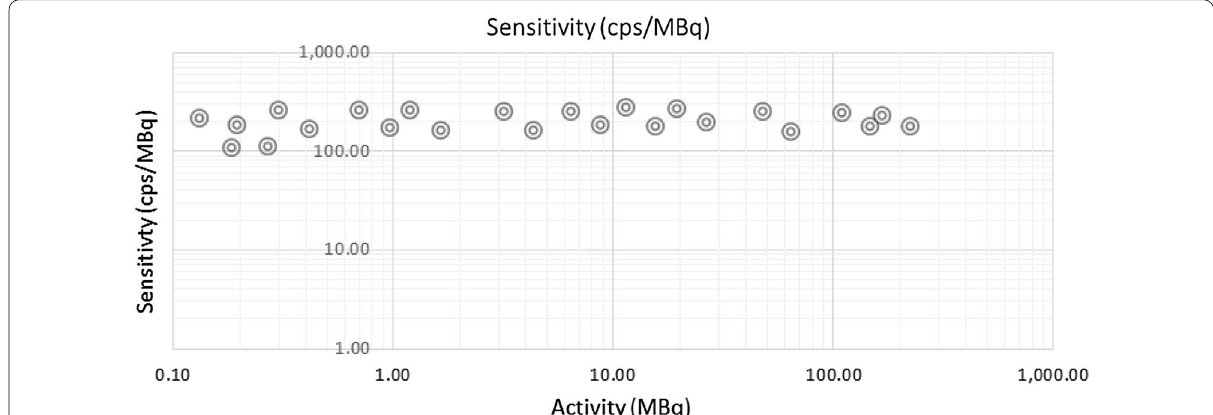
Fig. 6 System photon sensitivity for 3D imaging over a range of source activity